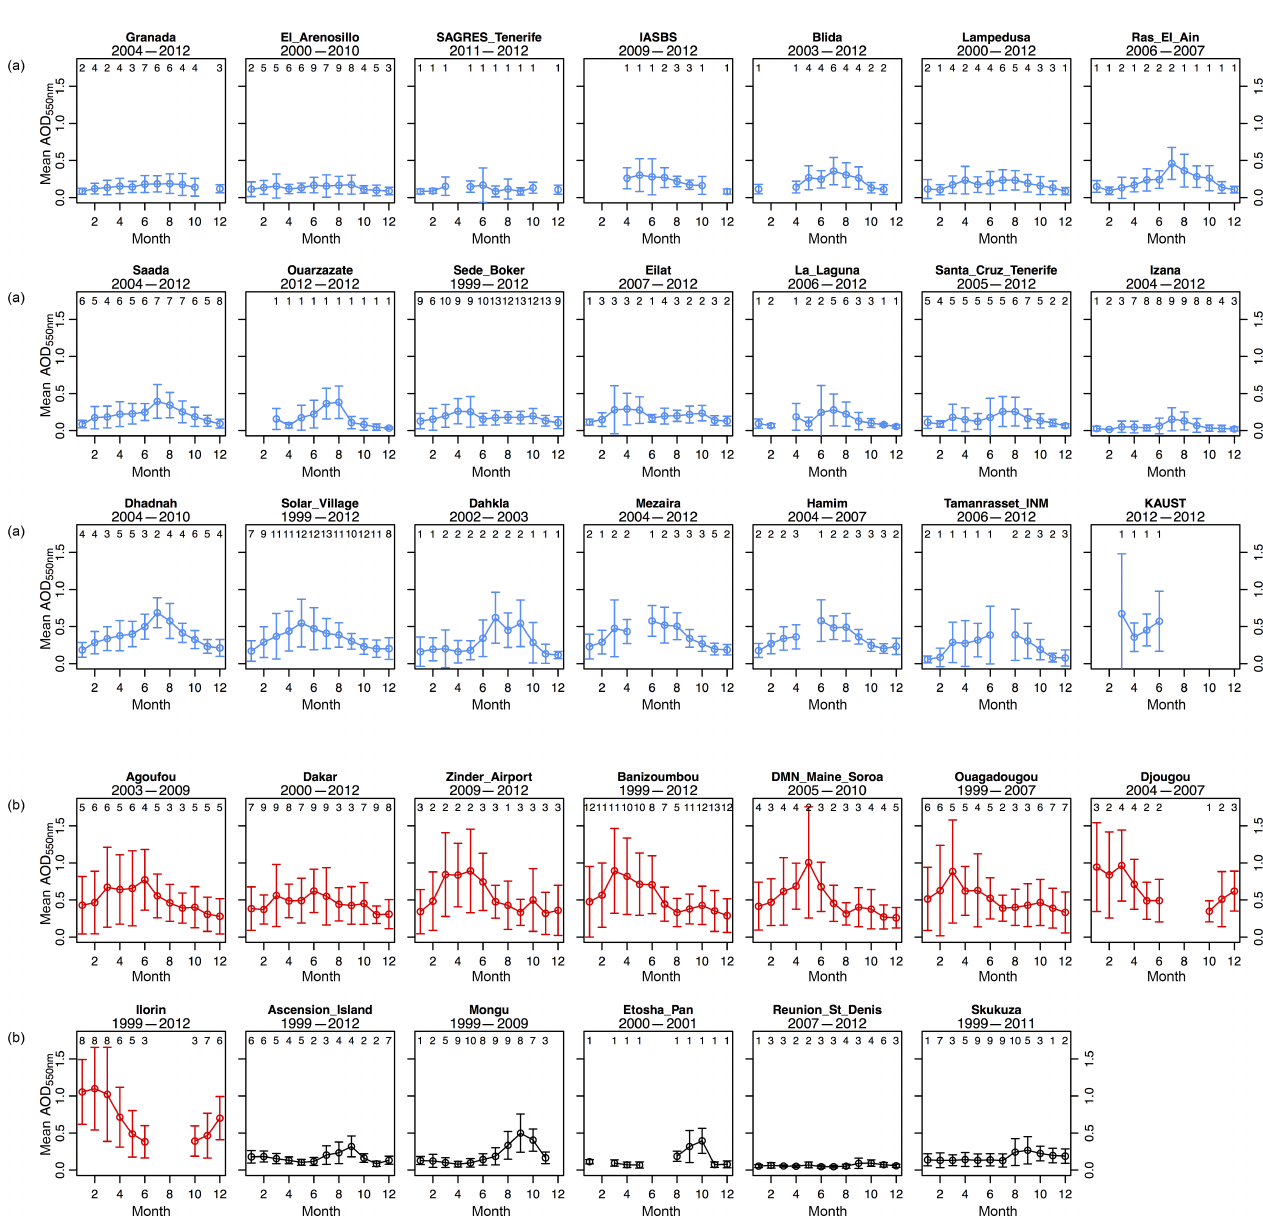
Figure 3. (a) Multiyear mean seasonal cycle of observed AERONET AOD 550nm at long-term sites in northern Africa and the Middle East. The number of years of data used for each month is shown at the top of the plot area, and the total range of years of observations used is listed under each site name. Whiskers are ± 1 standard deviation across daily means within a given month. (b) Multiyear mean seasonal cycle of observed AERONET AOD 550nm at long-term sites in western and southern Africa. The number of years of data used for each month is shown at the top of the plot area, and the total range of years of observations used is listed under each site name. Whiskers are ± 1 standard deviation across daily means within a given